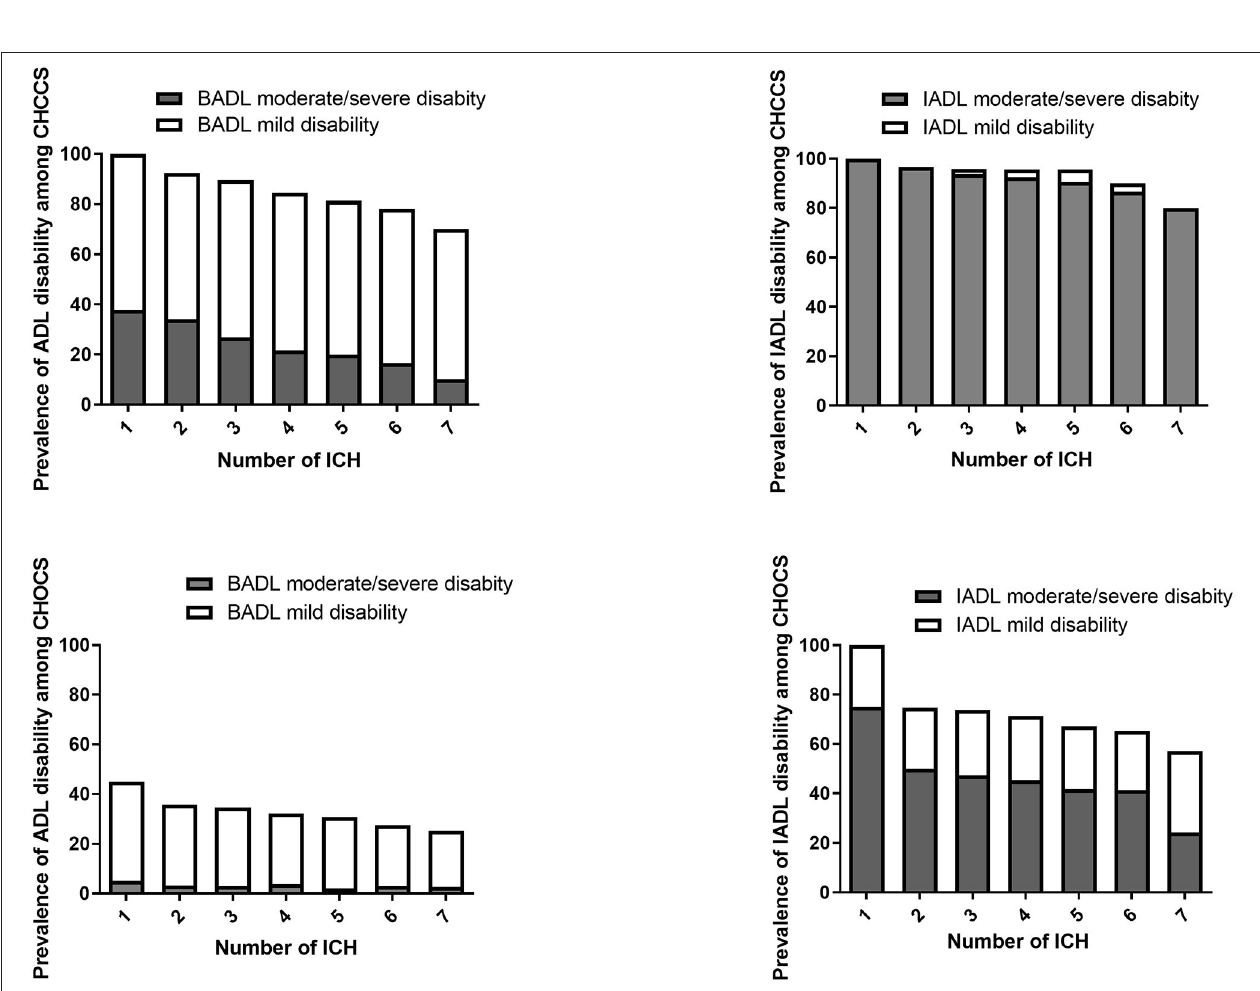
FIGURE 2 | BADL and IADL disability with number of ICH